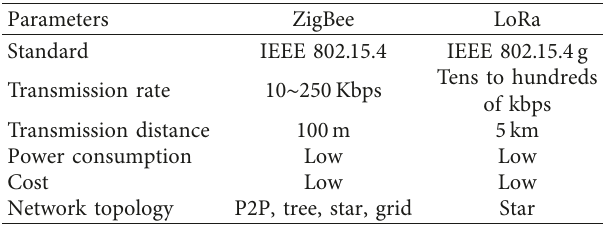
Table 1: Comparison of main parameters of ZigBee and LoRa communication